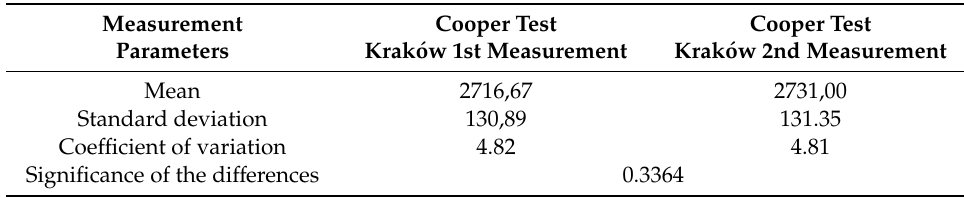
Table 1. The values of the stamina and performance parameters of the football players in the 1st and 2nd measurements in Krak ó